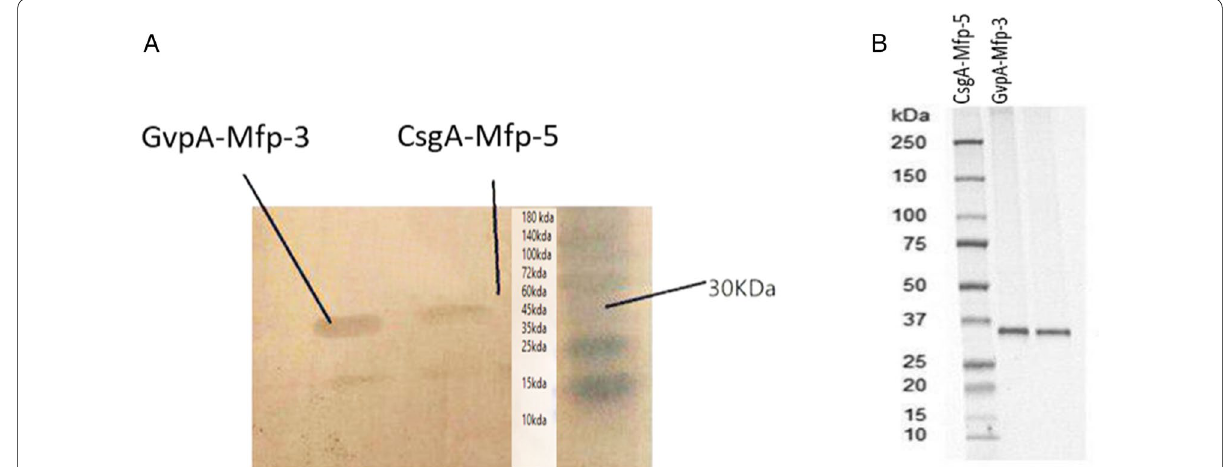
Fig. 3 Western blotting analysis for recombinant chimeric proteins before and after purification ( A and B